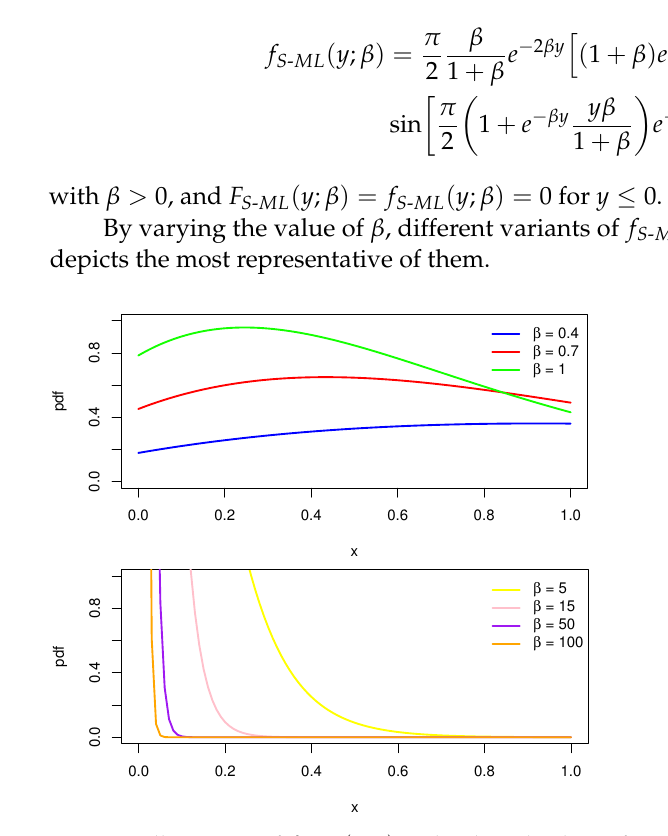
Figure 1. Illustration of f S - ML ( y ; β ) with selected values of β